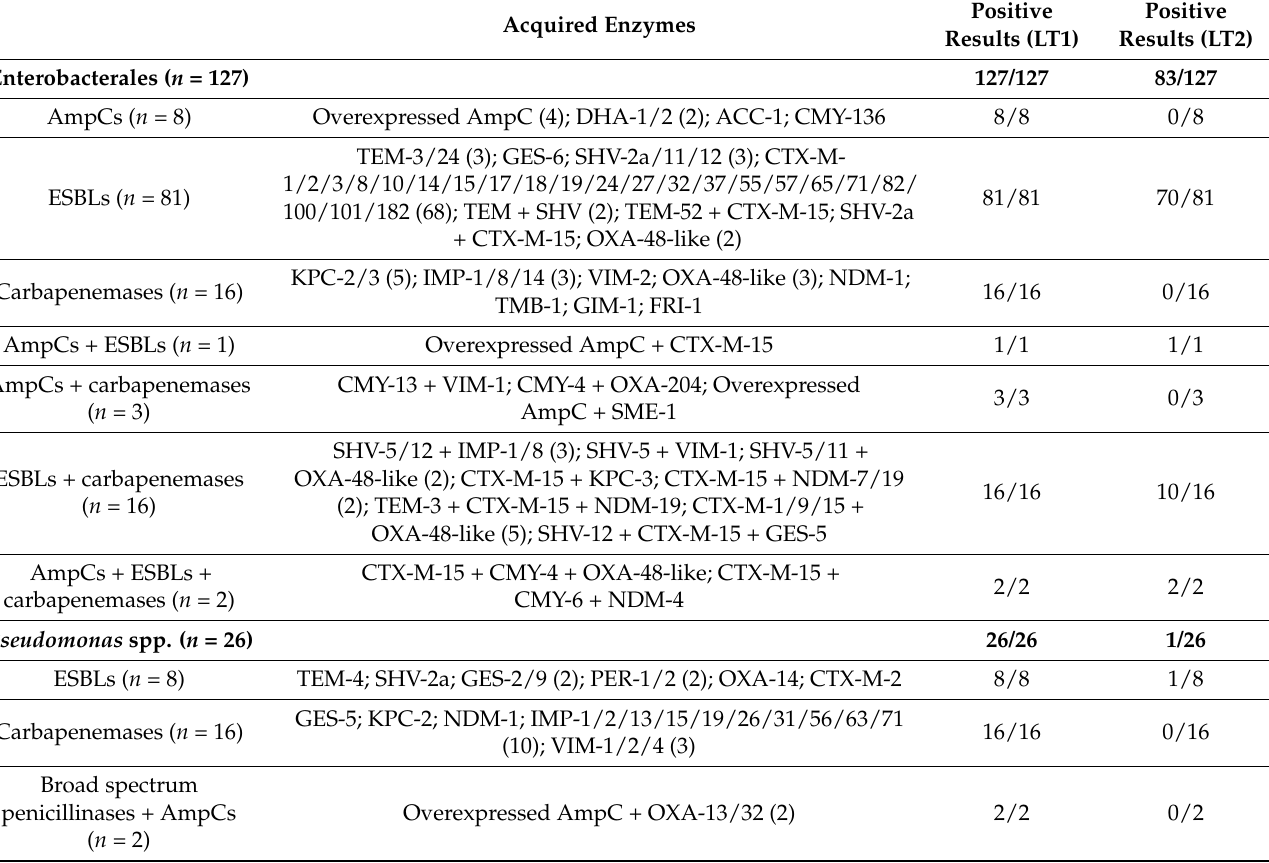
Table 2. LFIA Rapid ESC test results with 171 isolates with CTX-hydrolyzing activity. Acquired